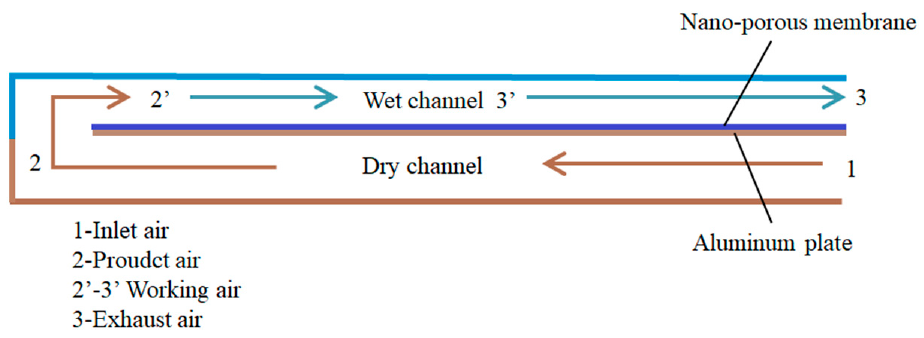
Figure 1. Working principle of membrane-based dew-point evaporative cooling system. Meanwhile, a circulating water pipe with several holes on the surface is attached at the bottom of the wet channel to supply the cooling water. The water feeding needs to